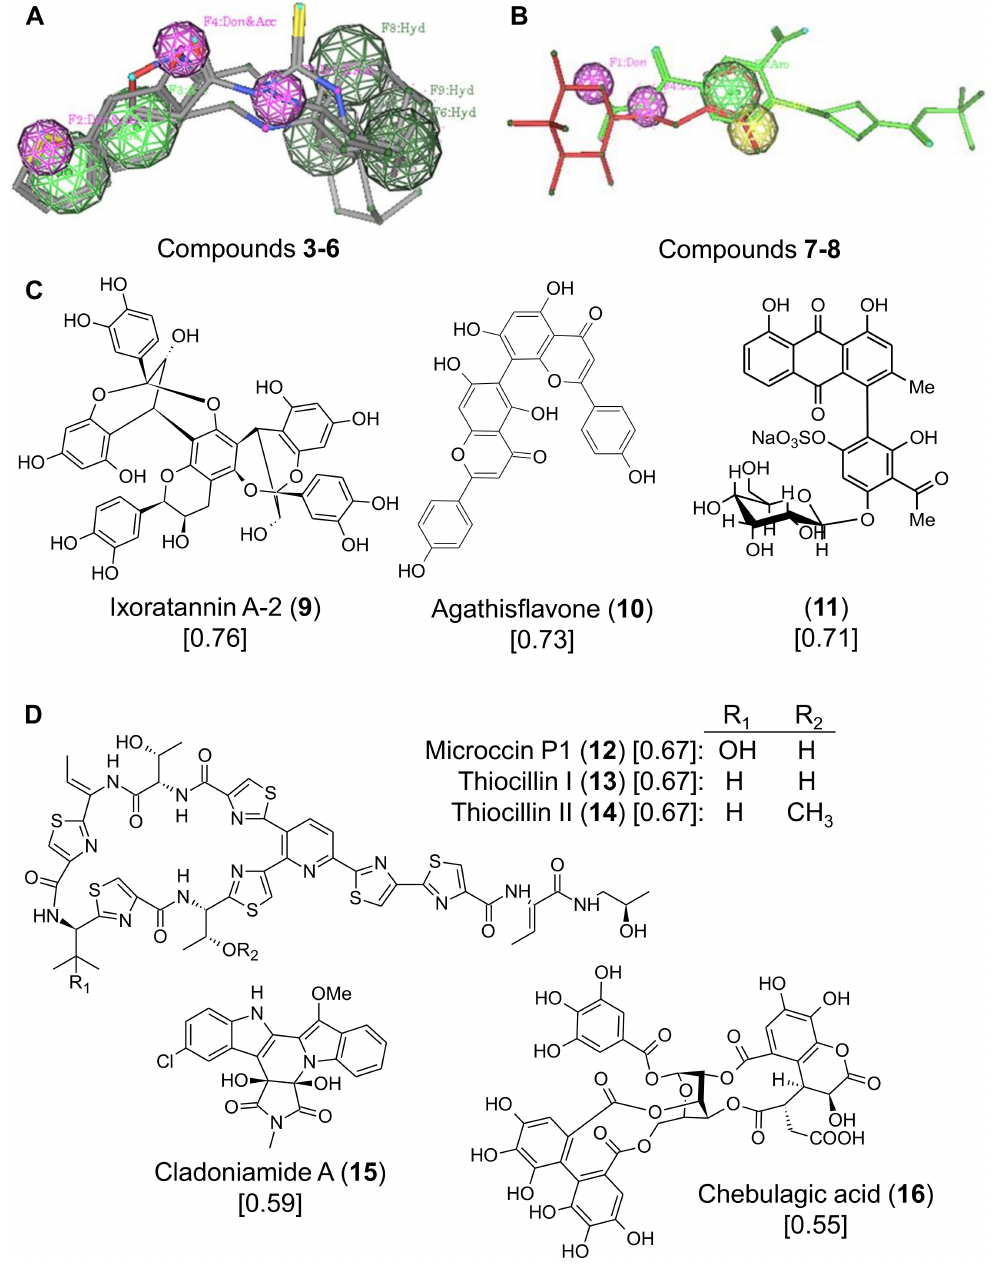
Figure 2. ( A , B ) Alignment of adamantane-class inhibitors ( A ) and non-adamantane-class inhibitors ( B ). Chemical moieties that define shared pharmacophores are highlighted. ( C ) Structures of three p-ANAPL molecules identified with pharmacophores shown in A , B . ( D ) Structures of five marine and terrestrial natural product molecules with shared pharmacophores. For each compound, the identified RMSD value is